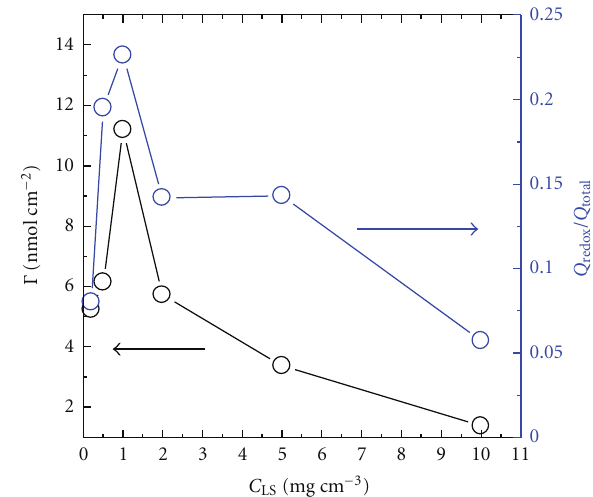
Figure 3: The e ff ect of LS concentration on the redox activity of the PEDOT/LS composite expressed as surface coverage of quinone groups and the ratio of redox peaks charge versus total CV charge. The calculations were made from CV curves recorded at 10mVs − 1 in phosphate bu ff er (pH